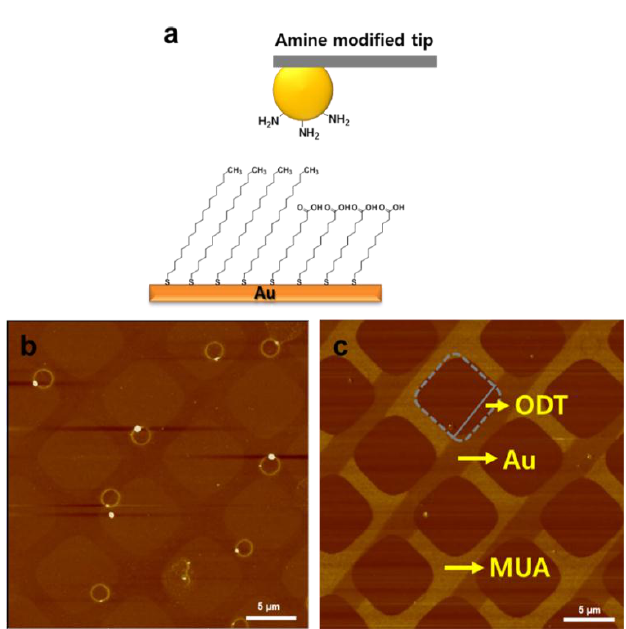
Figure 3. Chemical structure of the MUA/ODT pattern ( a ) Topography image ( b ) and Lateral force image ( c ) on the MUA/ODT pattern measured with an amine-modified ball tip (gray dash square: ODT pattern